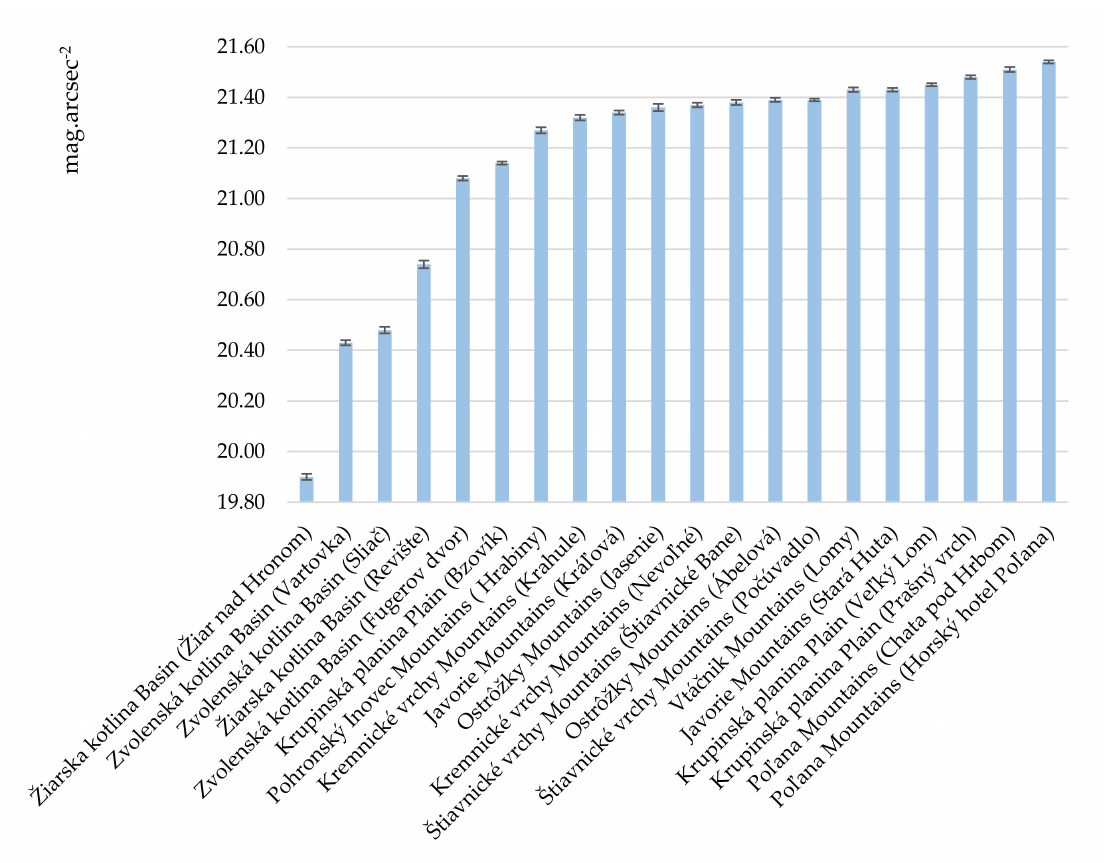
Figure 2. Mean and standard deviation for in situ measurements of night sky brightness at selected study